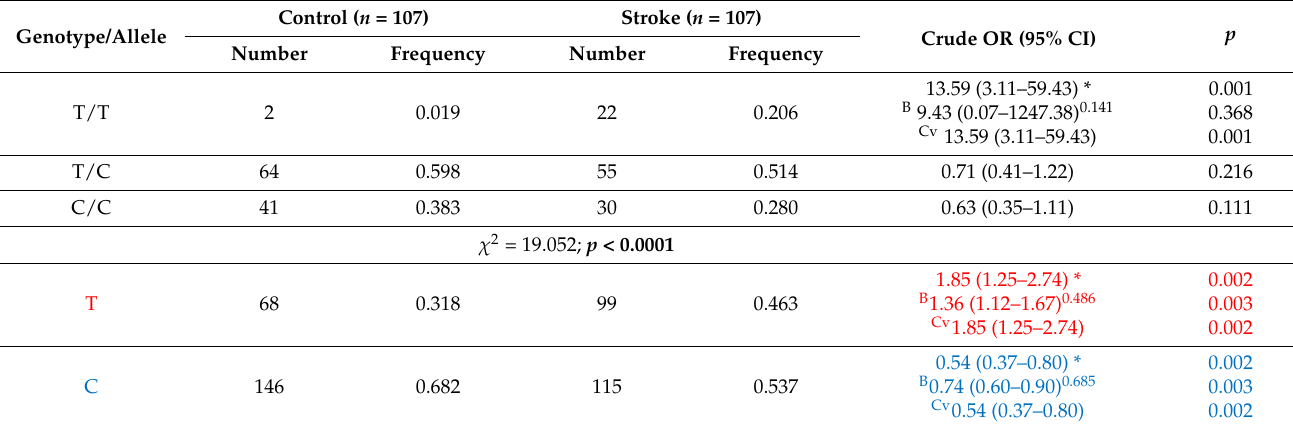
Table 4. Distribution of genotypes and alleles of the c.660T > A (rs713041) polymorphism in the GPX4 gene and odds ratios (ORs) with 95% confidence intervals (95% CIs) in patients with stroke and controls.